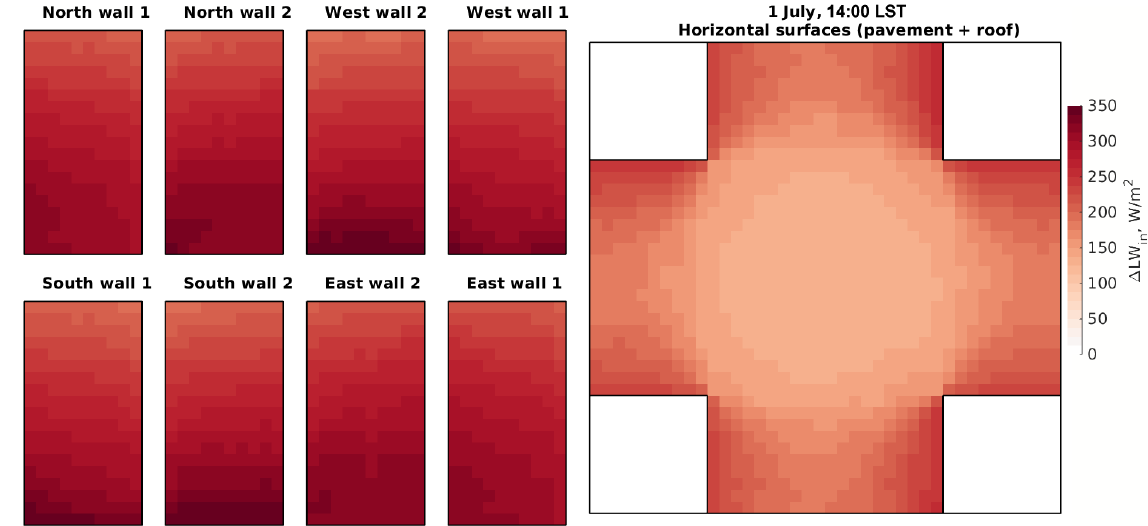
Figure 10. Changes in the received diffuse LW radiation flux within the focus domain of the simple urban configuration when considering surface thermal emissions (RTM_04) compared to the RTM_03. Walls, roofs, and pavements are folded the same way as those in Fig. 6.